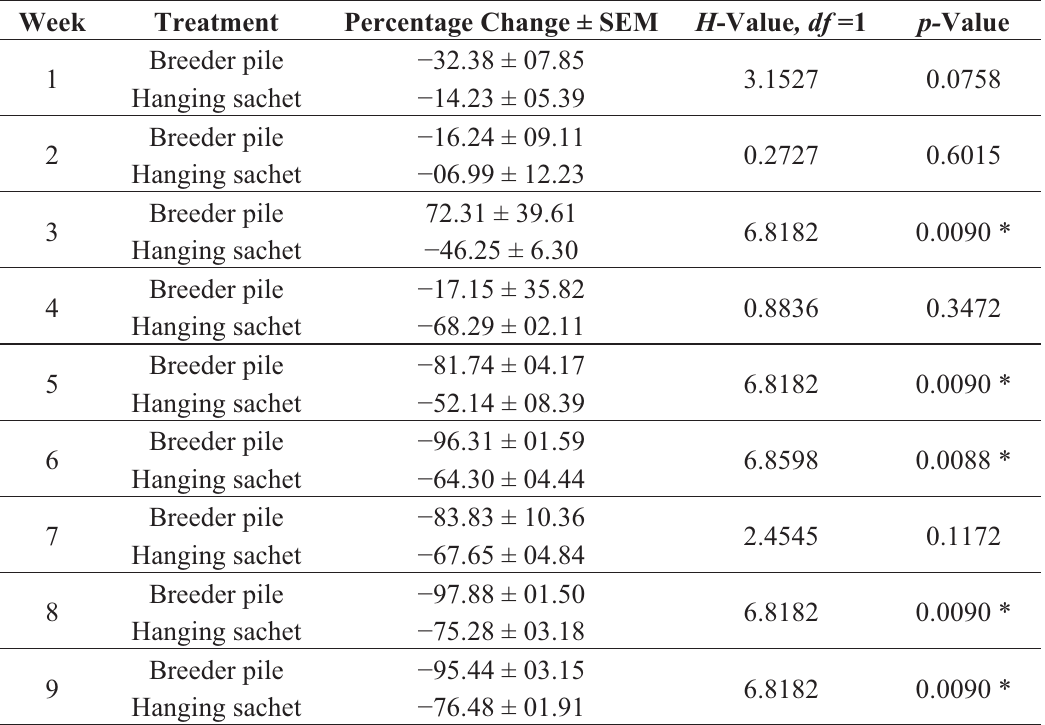
Table 4. Percentage change ± SEM of mean T. putrescentiae densities in treatments after introduction in experiment 1, trial 1. * indicates significant differences between treatments (Kruskal- Wallis, α =